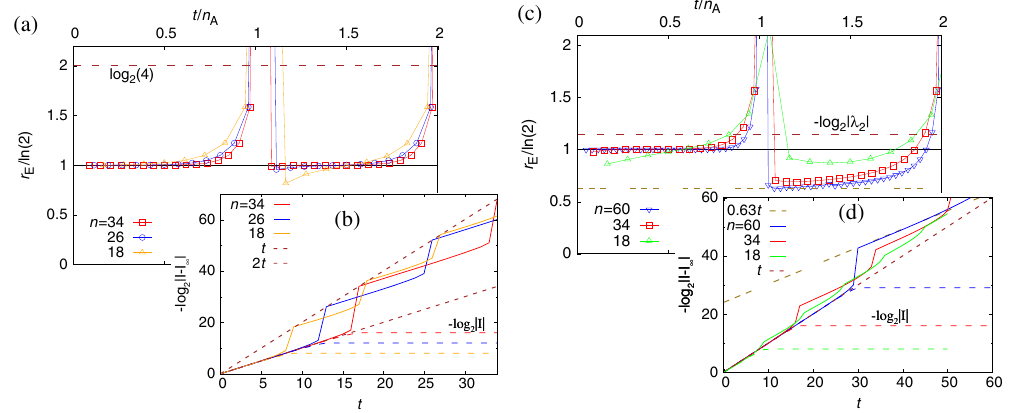
0 (a,b), and a 0 . 5 (c,d). For a 0 , the rate is always z ¼ z ¼ z ¼ 0 . 5 , the rate is again ln 2 for t < t n [see panel (b)]. For a ; A z ¼ c ¼ A ≈ 0 . 63 ln 2 at a 0 . 5 in (c,d), and is not equal to − ln j λ 2 j ]. E z ¼